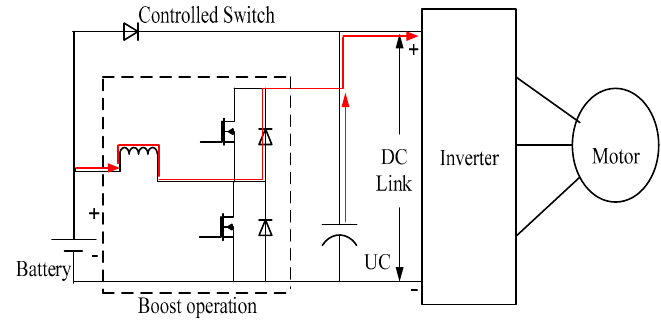
Figure 7. Acceleration mode.